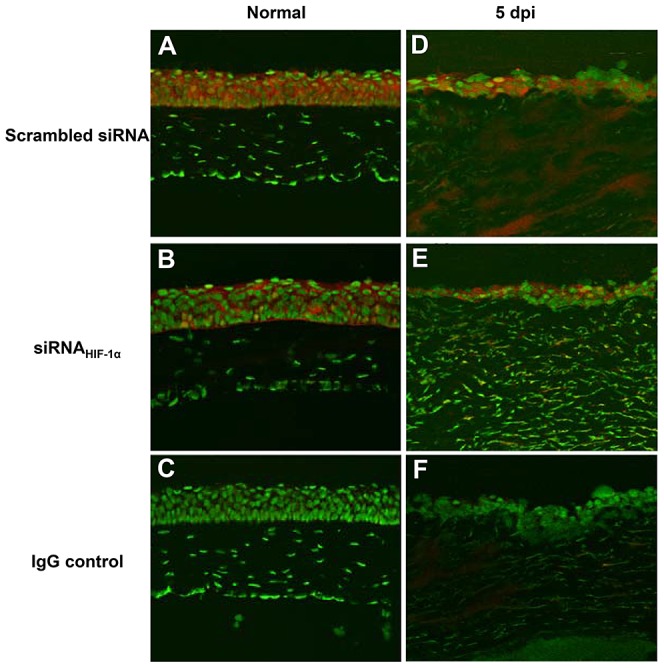
Immunostaining for HIF-α expression.Positive staining was detected in the epithelium of normal, uninfected corneas of both scrambled siRNA (A)- and siRNAHIF-1α-treated (B) mice. At 5 days p.i., increased HIF-1α expression was observed throughout the epithelium and stroma of scrambled siRNA-treated mice (D); while siRNAHIF-1α-treatment (E) revealed considerably less staining, indicating efficient knock-down of HIF-1α expression. IgG controls (C, F) were negative for staining. Representative results from two independent experiments (three mice per group per time point) are shown. Magnification = 185×.